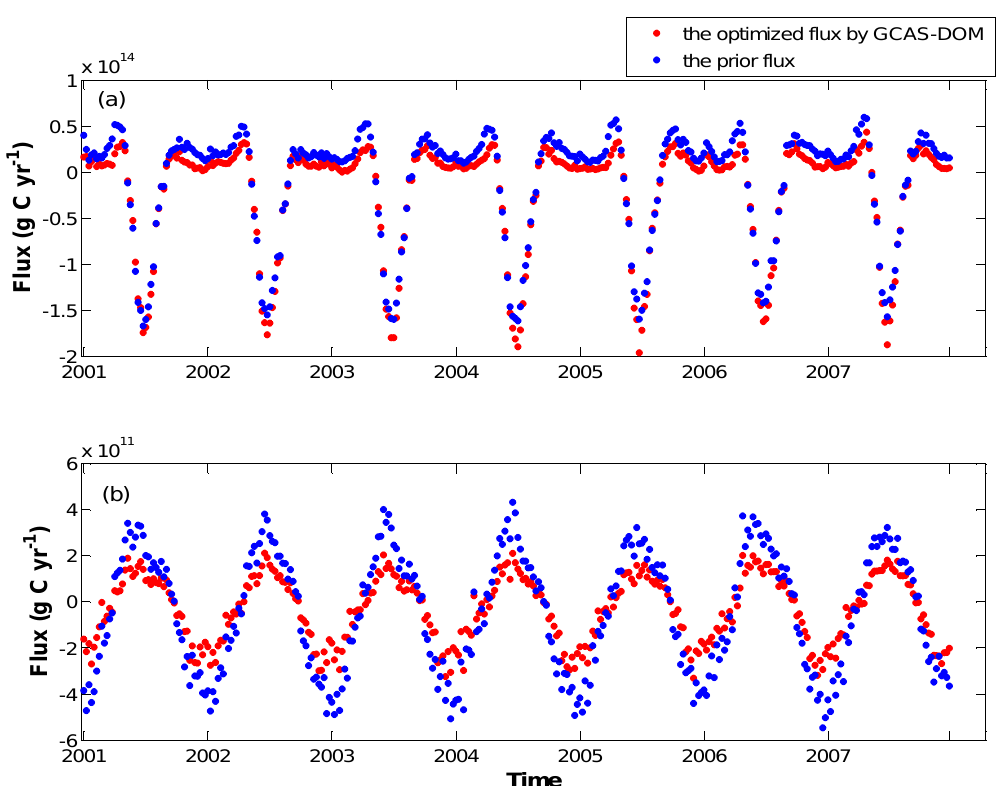
Figure 8. Weekly fluxes for coniferous forest. (a) Northern Hemisphere (b) Southern Hemisphere. All units are in gCyr − 1 . Note that different scales are used.